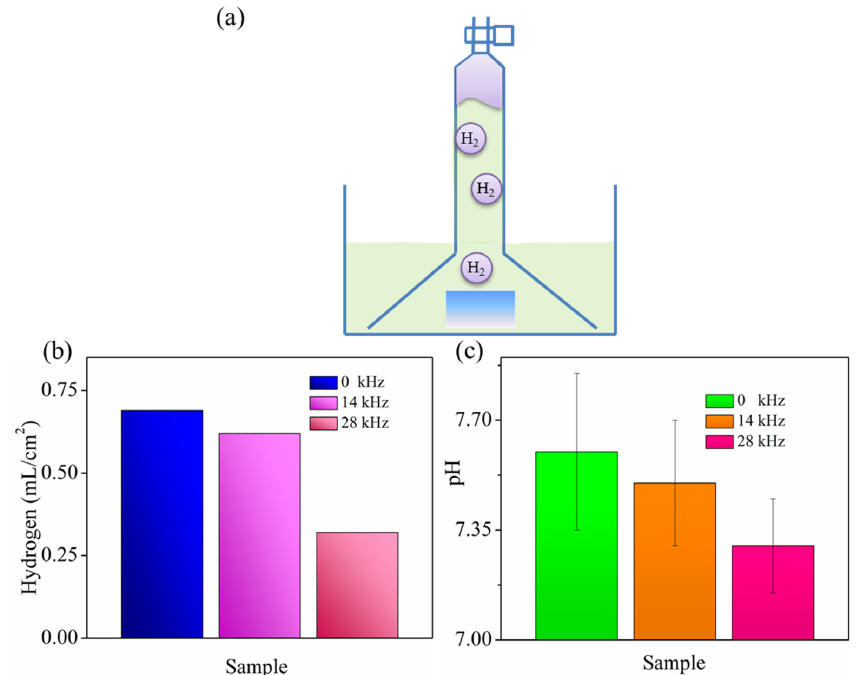
Figure 7. Immersion test results in a 3.5% NaCl solution for 24 h: ( a ) schematic diagram of immersion test, ( b ) hydrogen evolution and ( c ) pH changes of solution.